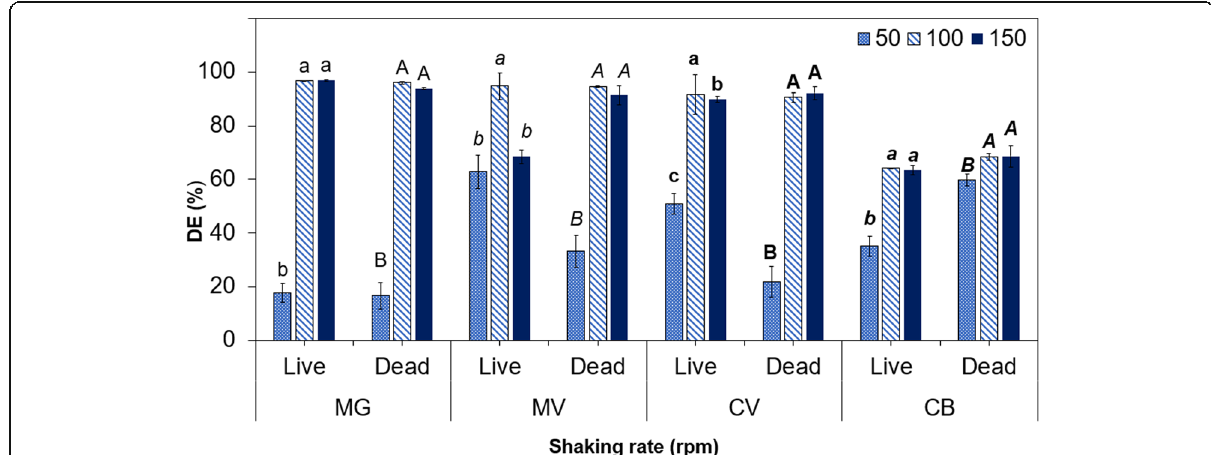
Fig. 5 Effect of agitation speed on the DE of TPM dyes by Streptomyces isolate (live and dead cells). Means with the same letters (lowercase, live cells; uppercase, dead cells) and font style (MG, regular; MV, italic; CV, bold; CB, bold italic) are not significantly different at HSD ( 0.05 ). Bars indicate ± SEM